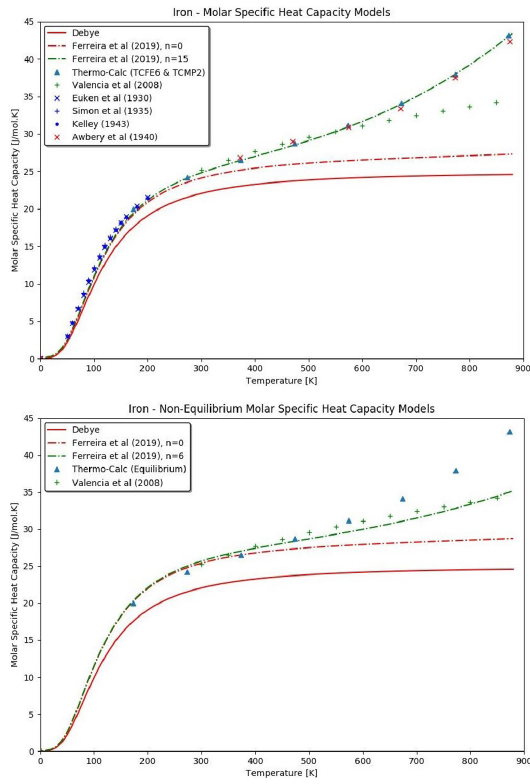
Figure 3. Comparison of the molar heat capacity of pure Fe by applying Debye, Thermo-Calc, and Ferreira et al. 17 , and Valencia and Quested 31 , ( A ) equilibrium, and, ( B ) non-equilibrium.